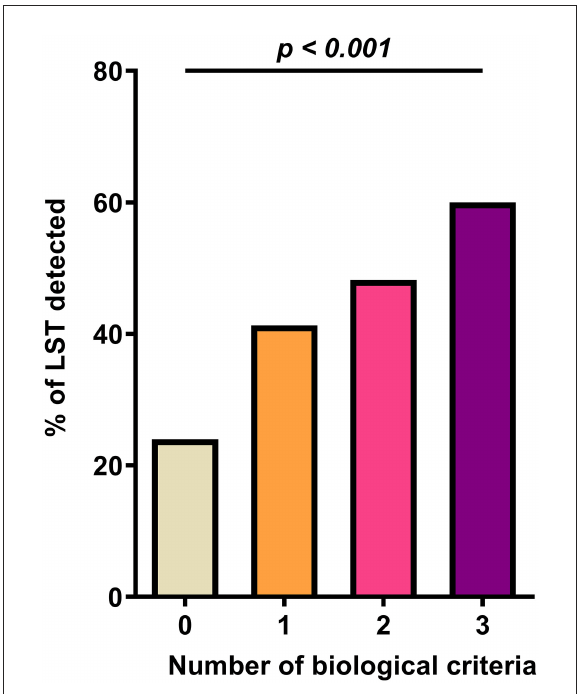
FIGURE2 Composite biological criteria (D-dimer, NT-pro-BNP/BNP, and creatinine) help predict LST decision.